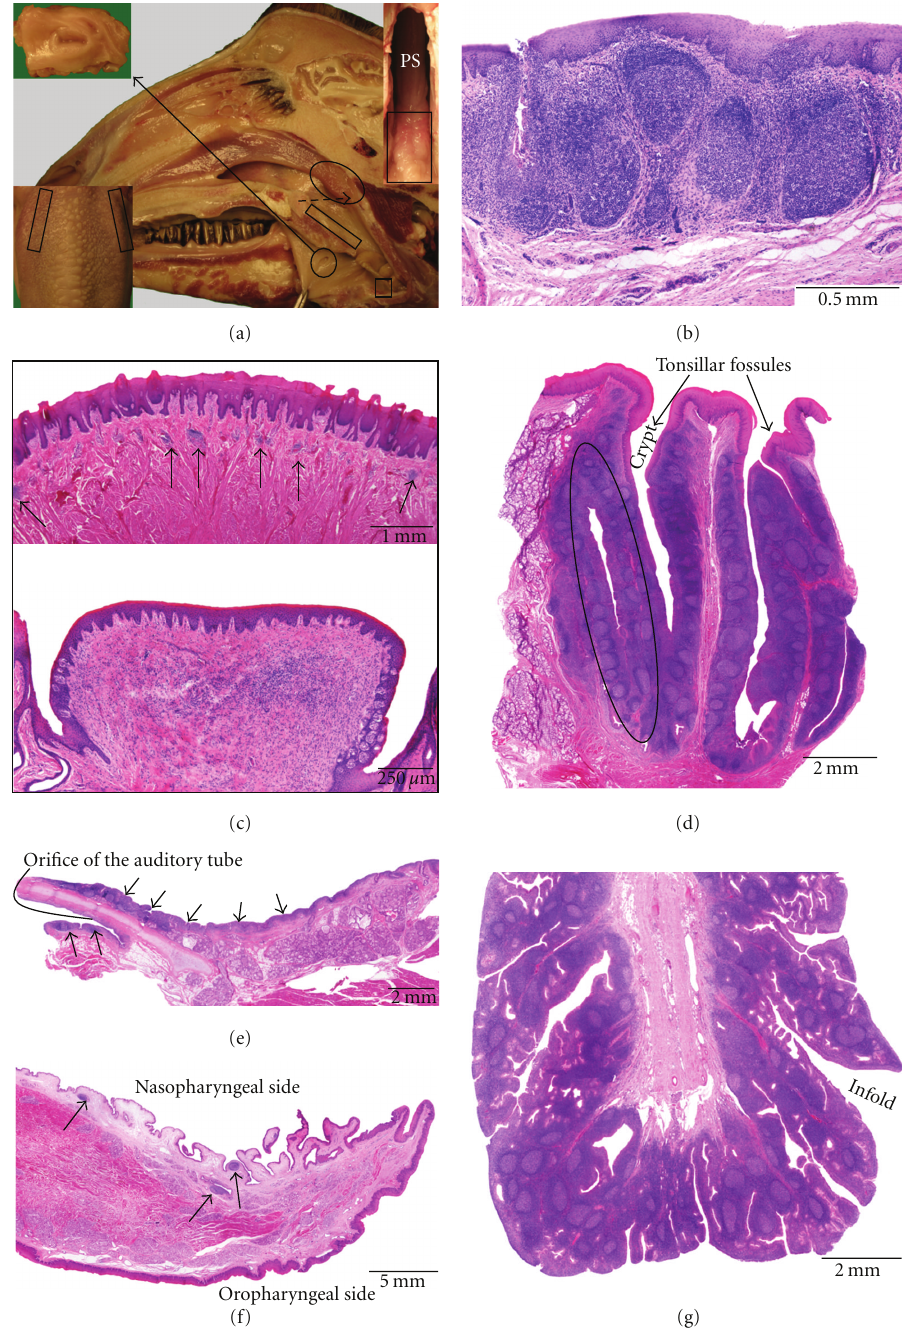
Figure 2: Anatomical localization and histological characteristics of the caprine tonsils. (a) Median section through a caprine head. A detail of the palatine tonsil is presented in the upper left insert. The location of the lingual tonsil, in the region of the vallate papillae, is shown in the lower left insert (dorsal view). The paraepiglottic tonsil that is located lateral to the basis of the epiglottis (small square box) is only present in a minority of goats. The position of the tonsil of the soft palate at the nasopharyngeal side of the soft palate is indicated by the rectangular box. At the caudal end of the pharyngeal septum (PS in the upper right insert), the pharyngeal tonsil (encircled on the overview, delineated by the rectangular box in the upper right insert) can be recognized by the numerous mucosal folds. The tubal tonsil is located caudoventral to the opening of the auditory tube, but is not visible on this view. (b) Histological section through the paraepiglottic tonsil. (c) Histological images of the lingual tonsil. The upper view shows aggregations of lymphoid cells (arrows) in between the lingual muscles and salivary glands. The lower image demonstrates the presence of an aggregation of lymphoid cells in the connective tissue core of a vallate papilla. (d–g) Histological sections through the palatine (d) and tubal (e) tonsils, the tonsil of the soft palate (f), and the pharyngeal tonsil (g), respectively. A tonsillar follicle is encircled in (d); the lymphoid tissue in (e) and (f) is indicated by the